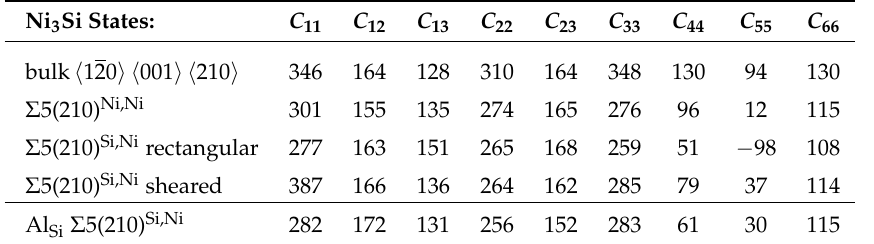
Table 2. The computed elastic constants (all in GPa) of (i) the Ni 3 Si bulk in the coordination system of the studied GBs (shown in Figure 1), (ii) two types of Ni 3 Si Σ 5(210) GBs with different atoms (see Figure 1) at the interface and (iii) systems with Al atom substituting Si atom within the GB interface plane Ni 3 (Si,Al Si ) Σ 5(210) Si,Ni . In the case of Σ 5(210) Si,Ni we list elastic constants for the rectangular-parallelepiped supercells (these systems are mechanically not stable) as well as the shear-deformed ones (these are mechanically